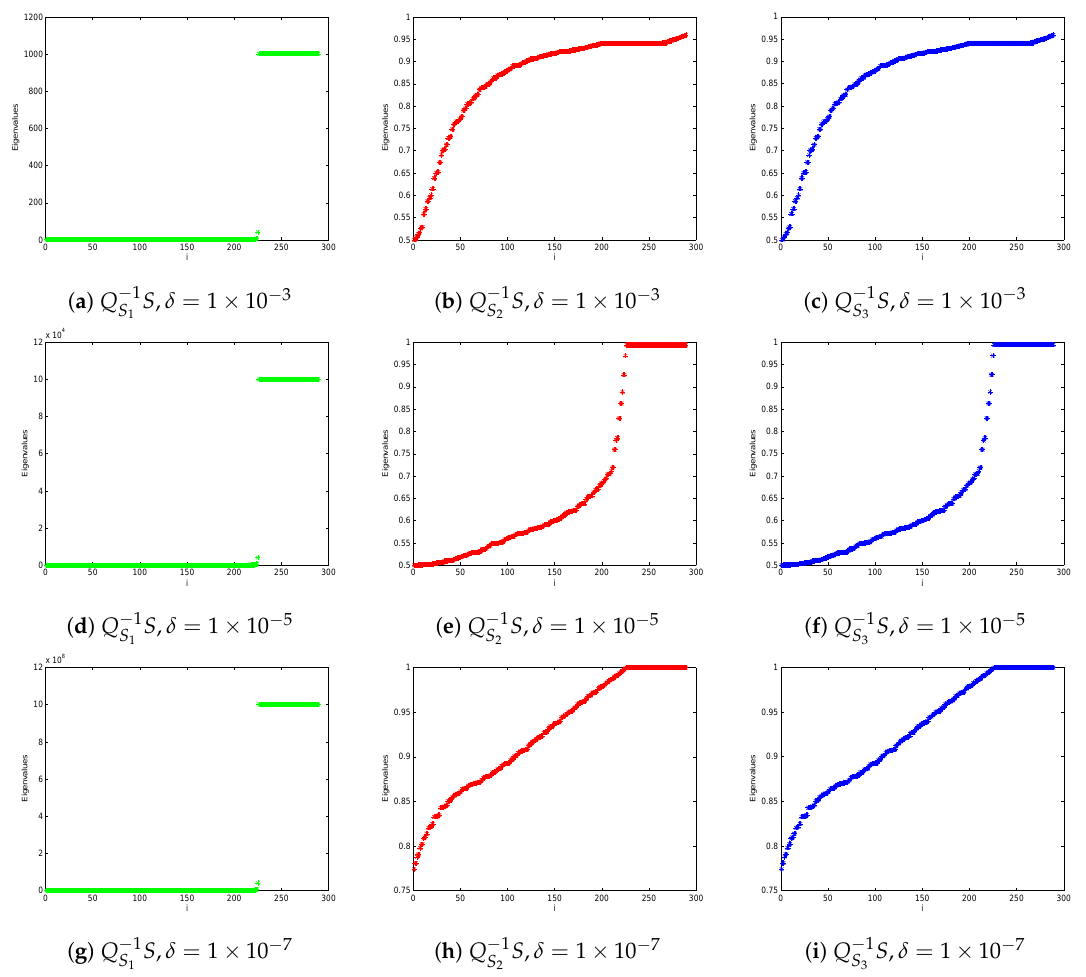
S [ a , d , g ] , Q − 1 S [ b , e , h ] and Q − 1 S [ c , f , i ] for δ = S 1 S 2 S 3